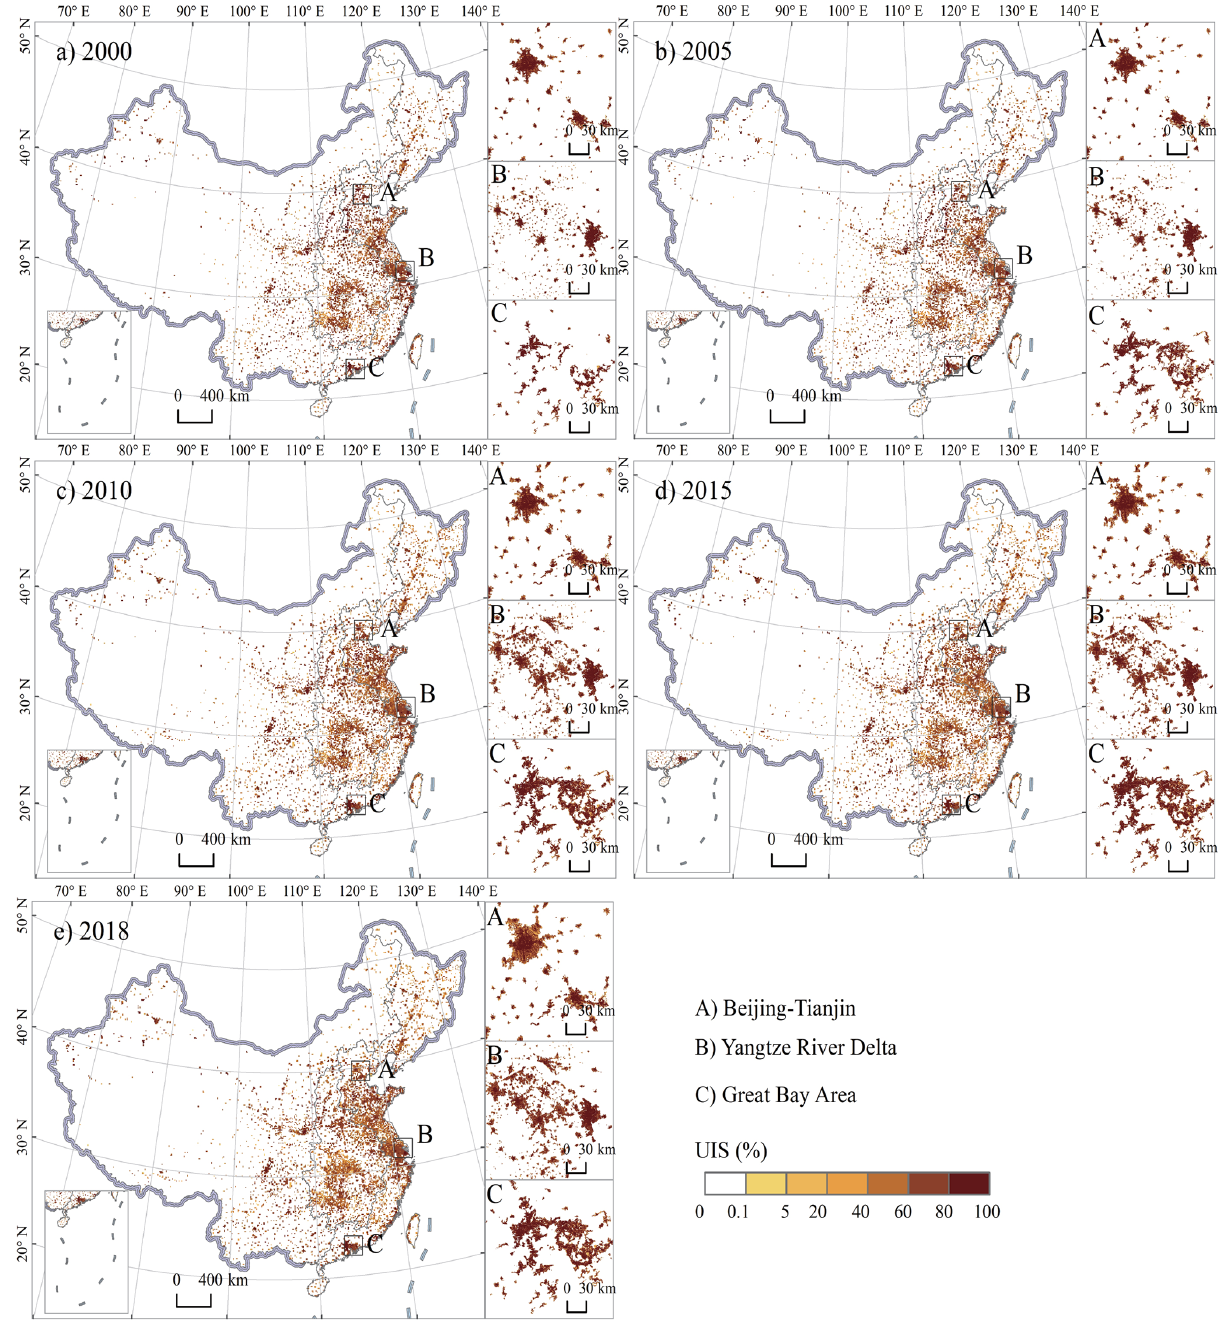
Figure 7. Spatial distribution of urban impervious surface (UIS) in 2000–2018 across China. The administrative boundaries were provided by the National Geomatics Center of China (http://www.webmap.cn, last access: 15 September 2020).